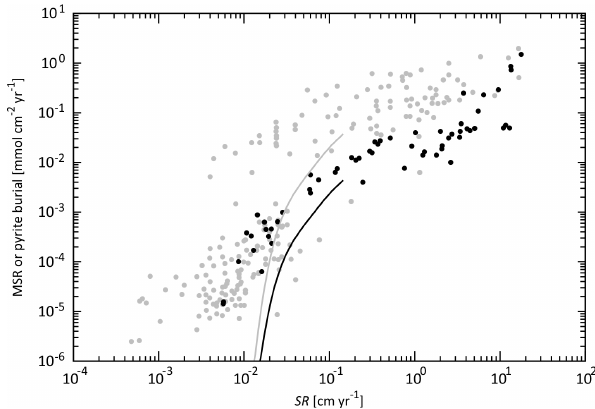
Figure 16. MSR and pyrite burial flux density as a function of sedi- mentation rate. Gray and black dots depict observational data com- pilation of depth-integrated MSR flux density and pyrite burial flux density for normal (oxic) marine sediments (Berner and Canfield, 1989; Canfield, 1989; Raiswell and Canfield, 2012). The unit of sedimentation rate was converted from gcm − 2 yr − 1 to cmyr − 1 , assuming a dry bulk density of 2.5gcm − 3 and porosity of 0.9. Solid lines are the results obtained from the reference run of the CANOPS-GRB